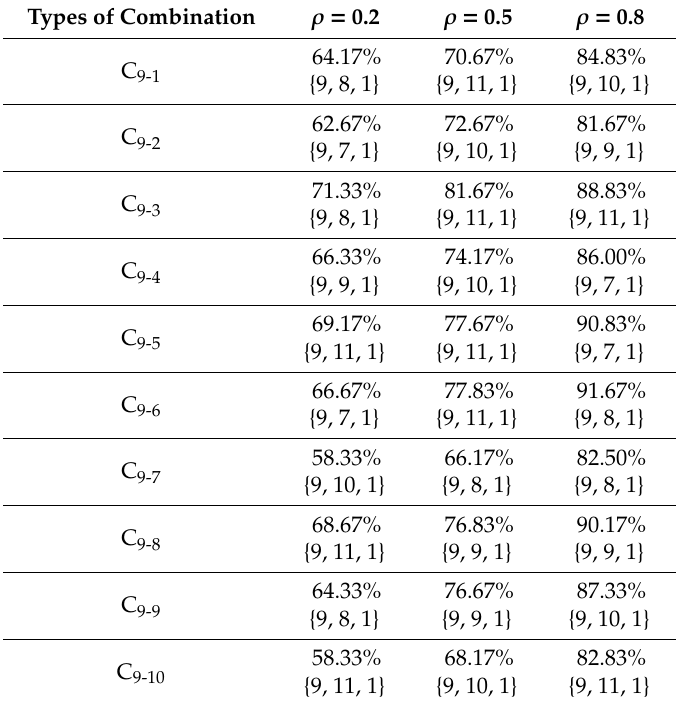
Table 5. ANN identification results, AIR -ANN {A ni , A nh , A no }, for ten combinations of faults of an MNP